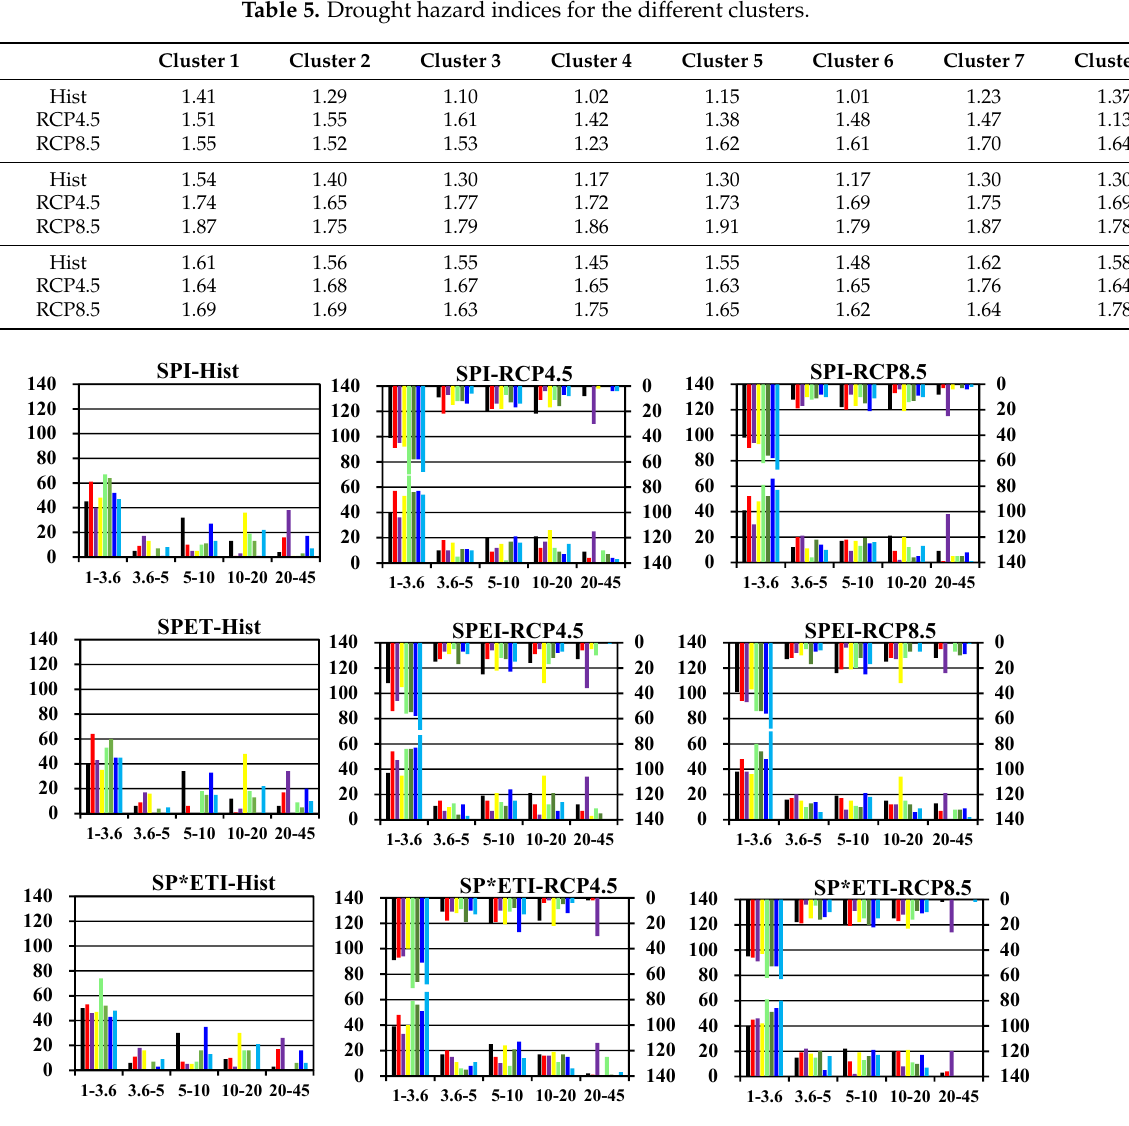
Figure 11. Average area percentages in clusters with different periodicities. The grouped bars on the lower X -axis represent the dominant average periodicities in the first half of the century (from 2021 to 2050), and the corresponding percentages of areas can be read on the left Y -axis (unit: %). The grouped bars on the upper X -axis represent the dominant average periodicities in the second half of the century (from 2071 to 2100), and the corresponding area percentages can be read on the right Y -axis (unit: %).